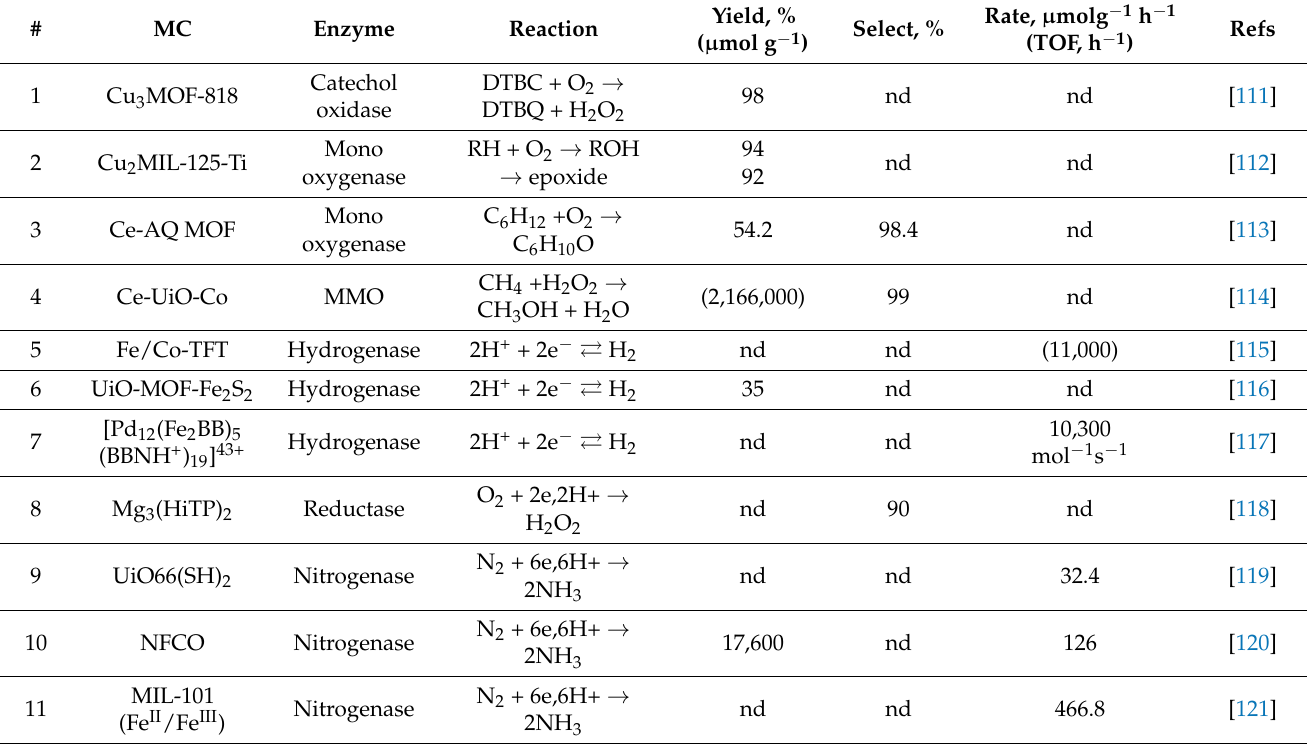
Table 2. Models of redox-active